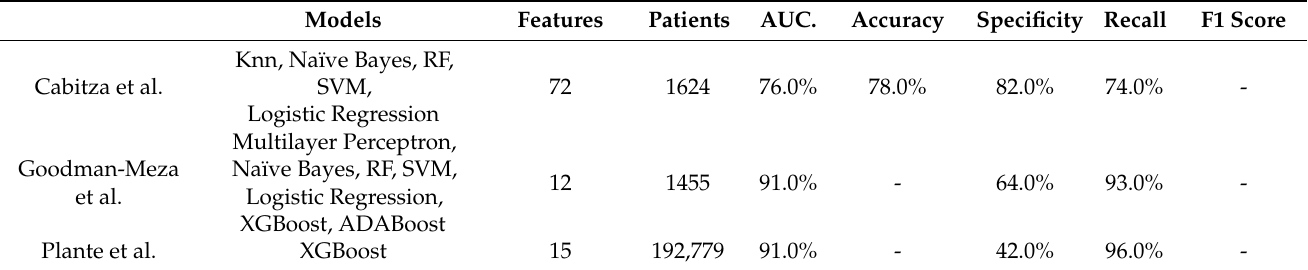
Table 4. State-of-the-art classification results from [23,26,36,41].